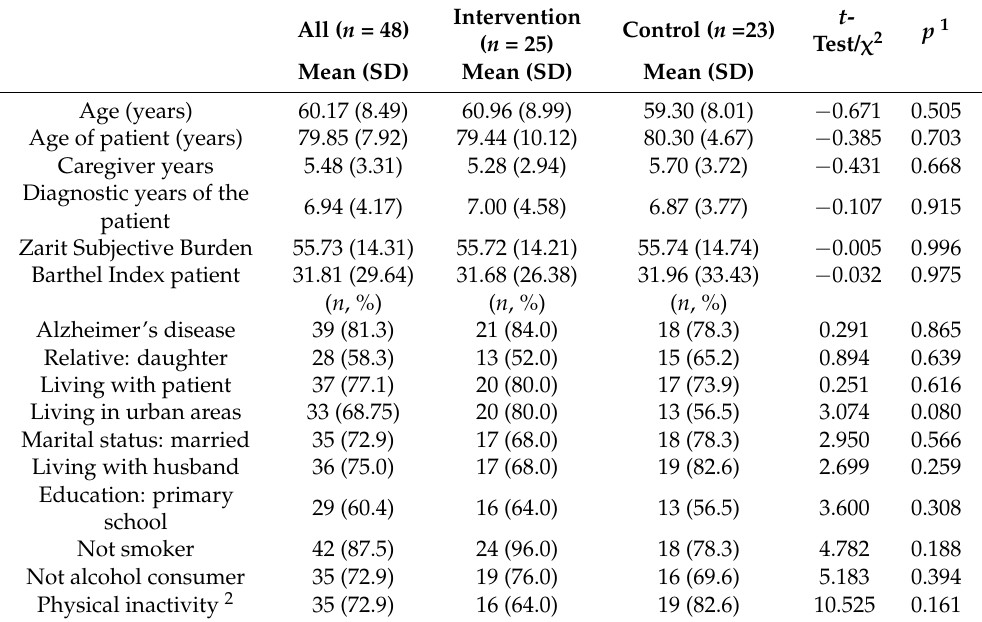
Table 1. Sociodemographic and caregiving-related characteristics of participants at